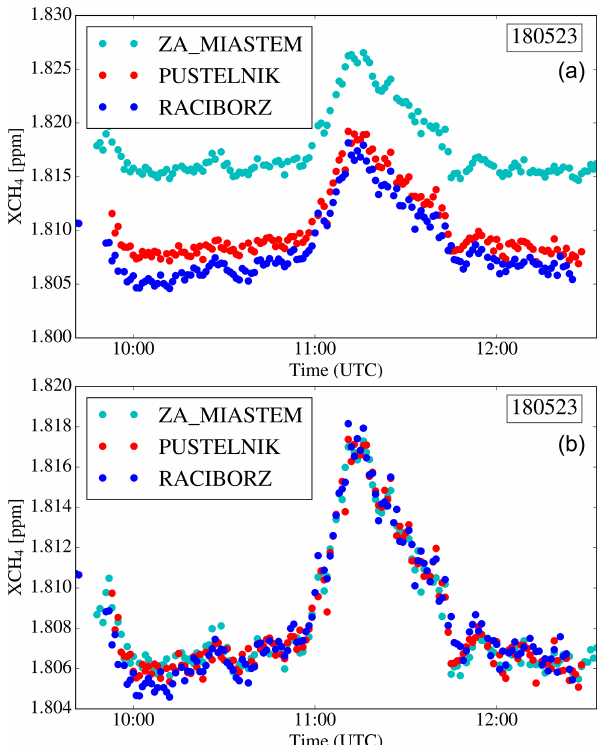
Figure 2. Side-by-side measurements at station Pustelnik (S) on 23 May 2018 on the first day of the deployment. (a) Unscaled data with an average instrument-to-instrument difference of 5ppb. (b) Measured XCH 4 after scaling with about 1ppb of instrument-to- instrument difference. Note that the instruments detected a plume- like structure at the beginning of the measurements and around 11:20UTC. The instrument for The Glade (E) measured side-by- side on 26 May with the Pustelnik (S) instrument (data in Fig. A1).